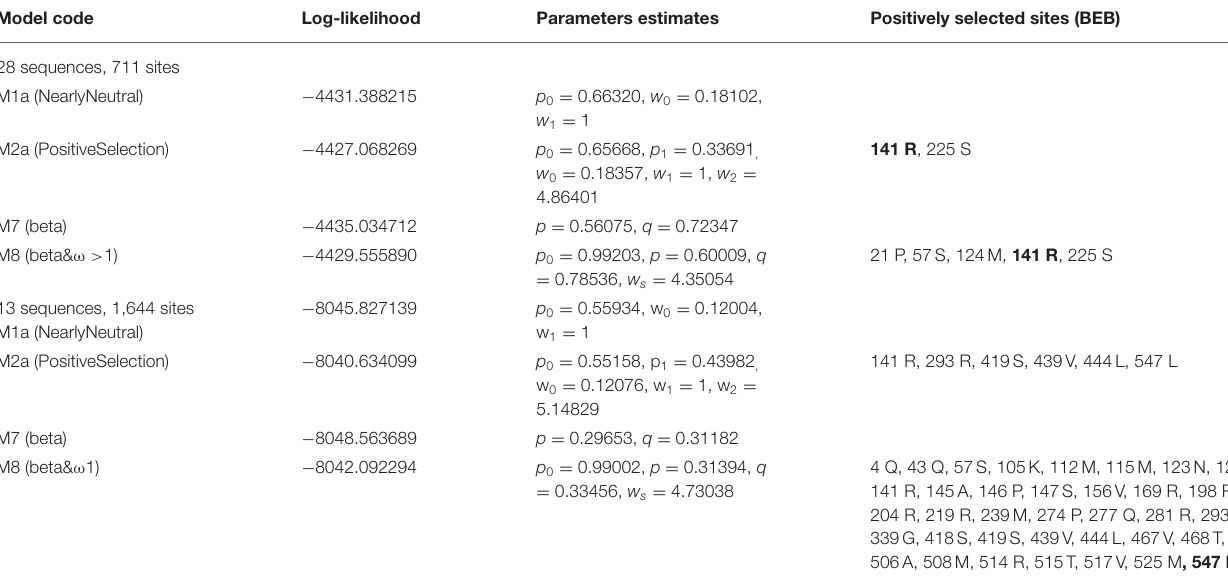
TABLE 4 | Results of maximum likelihood models of Zp4 of muroid